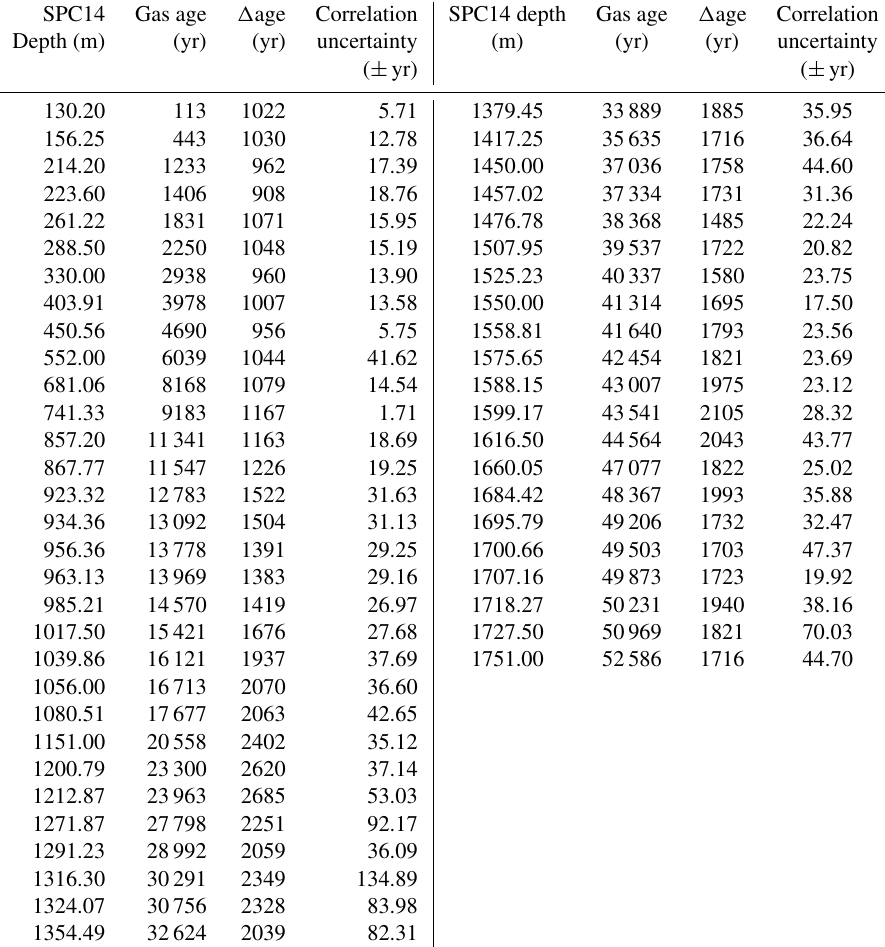
Table 1. Tie points used for chronology with (cid:49) age and uncertainty. Uncertainties are listed at the tie points as correlation uncertainty and interpolation uncertainty. Interpolation uncertainty is given as the largest estimate for an interval between tie points. (cid:49) age is reported in years at each tie point. See Supplement for complete timescale uncertainties. 1950CE: 0